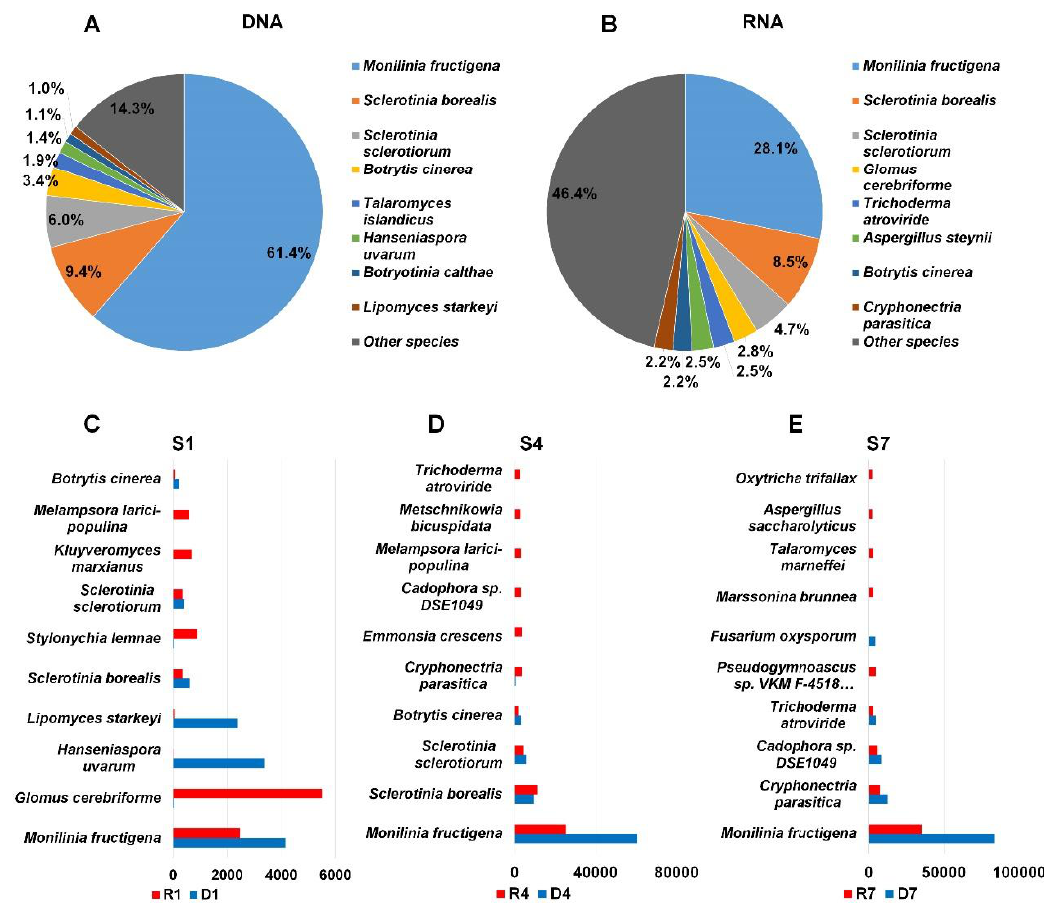
Figure 5. Proportion of major fungal species identified from three DNA and three RNA libraries. The proportion of major fungal species identified from three DNA ( A ) and RNA ( B ) libraries. The results of fungal species in each library were combined according to DNA and RNA libraries. The top ten fungal species in each sample, S1 ( C ), S4 ( D ), and S7 ( E ). Number indicates the number of raw sequence reads associated with corresponding fungal species. Red and blue colors indicate RNA and DNA libraries.